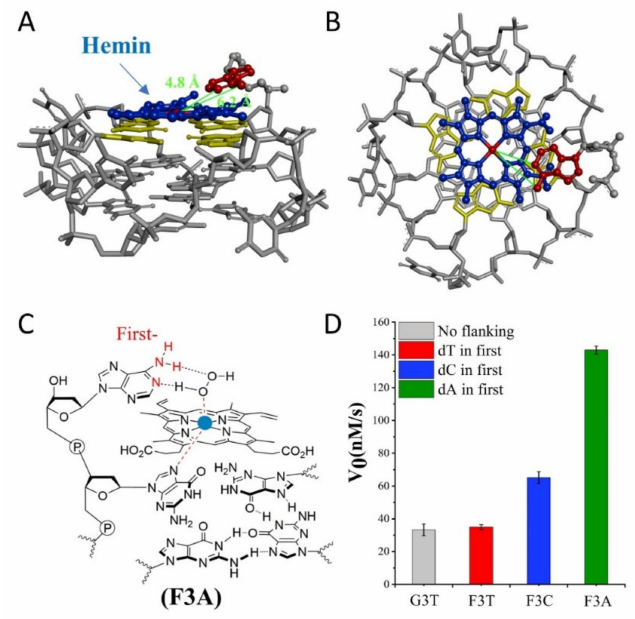
Figure 2. ( A , B ) Molecular model of F3A. A: side view, B: top view. Molecular docking studies were performed by PyMOL-2.3.1. with XRD crystal structure extracted from PDB:2LXV. ( C ) Schematic representation of hemin intermediate with F3A. The 3 (cid:48) flanking dA makes the 6-NH 2 and N1 group concertedly form two hydrogen bonds (N1-H-O α and 6-NH-H-O β ) with H 2 O 2 . ( D ) Summary of the catalytic activity of G3T and F3N.